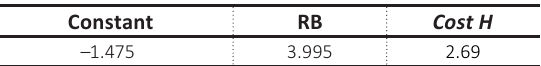
Table 4. Coefficients of the final logistic regression